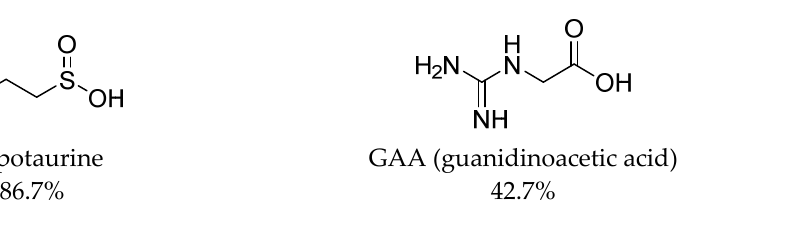
Figure 5. Ligands of SLC6A6 transporter. Biological activity of compounds was expressed as inhibition percentage of [ 3 H]-taurine uptake using TM4 cells in 1 mM screening concentration [69].